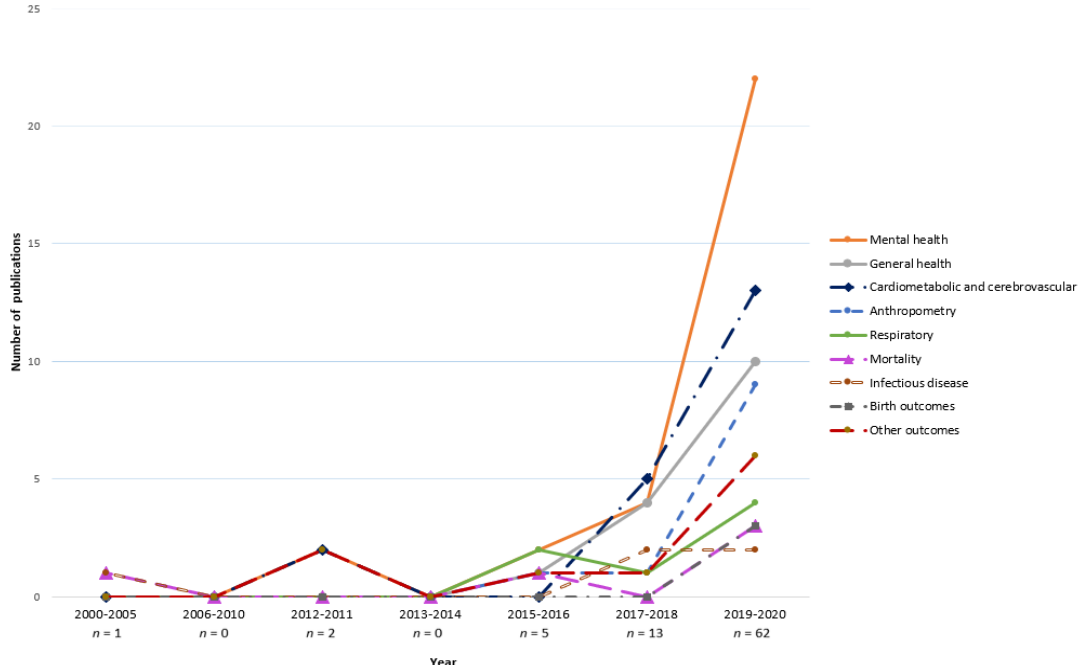
Figure 2. Publication trend by year and health outcomes. Some studies measured more than one outcome. n , total number of publications.